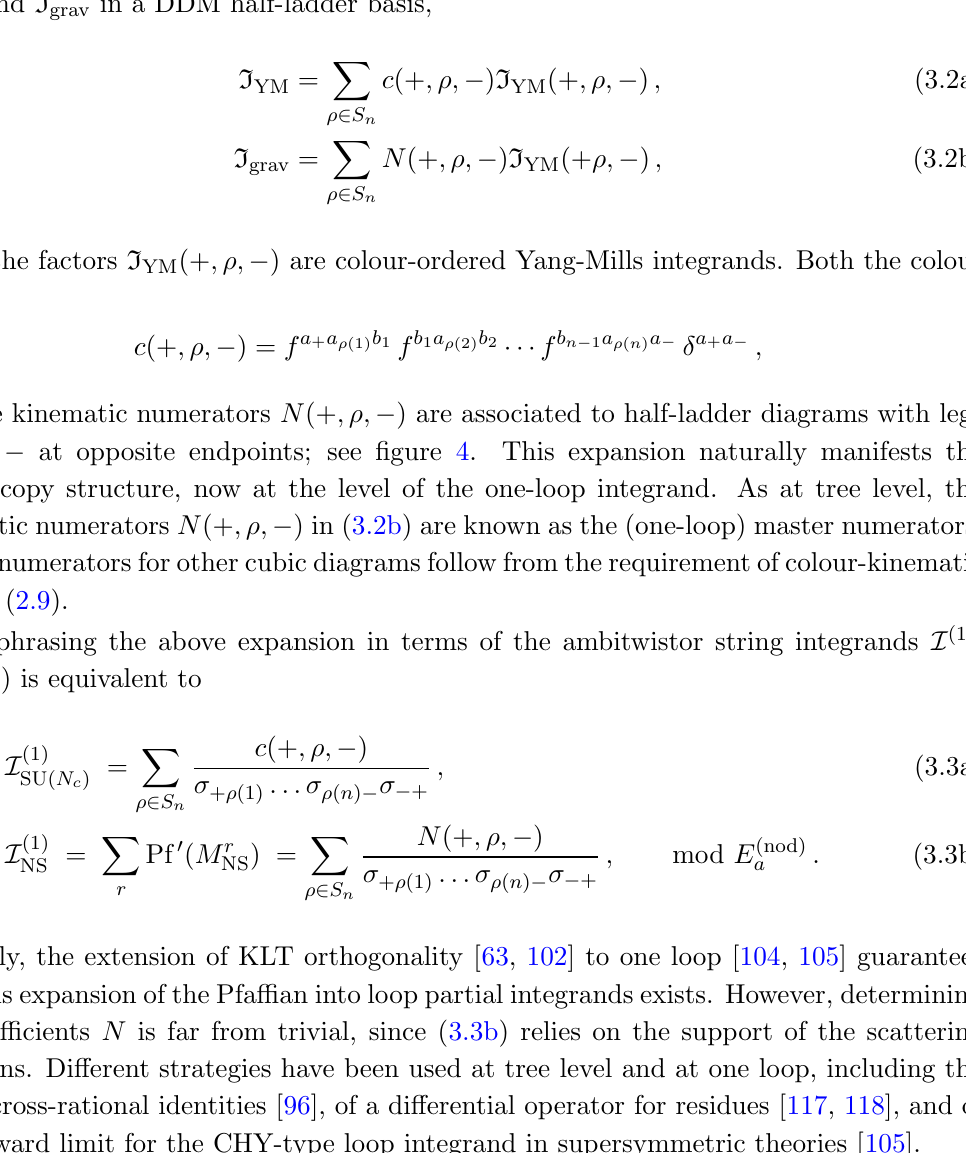
Figure 4 . The one-loop BCJ master numerators N diagrams with legs + and (cid:0) at opposite